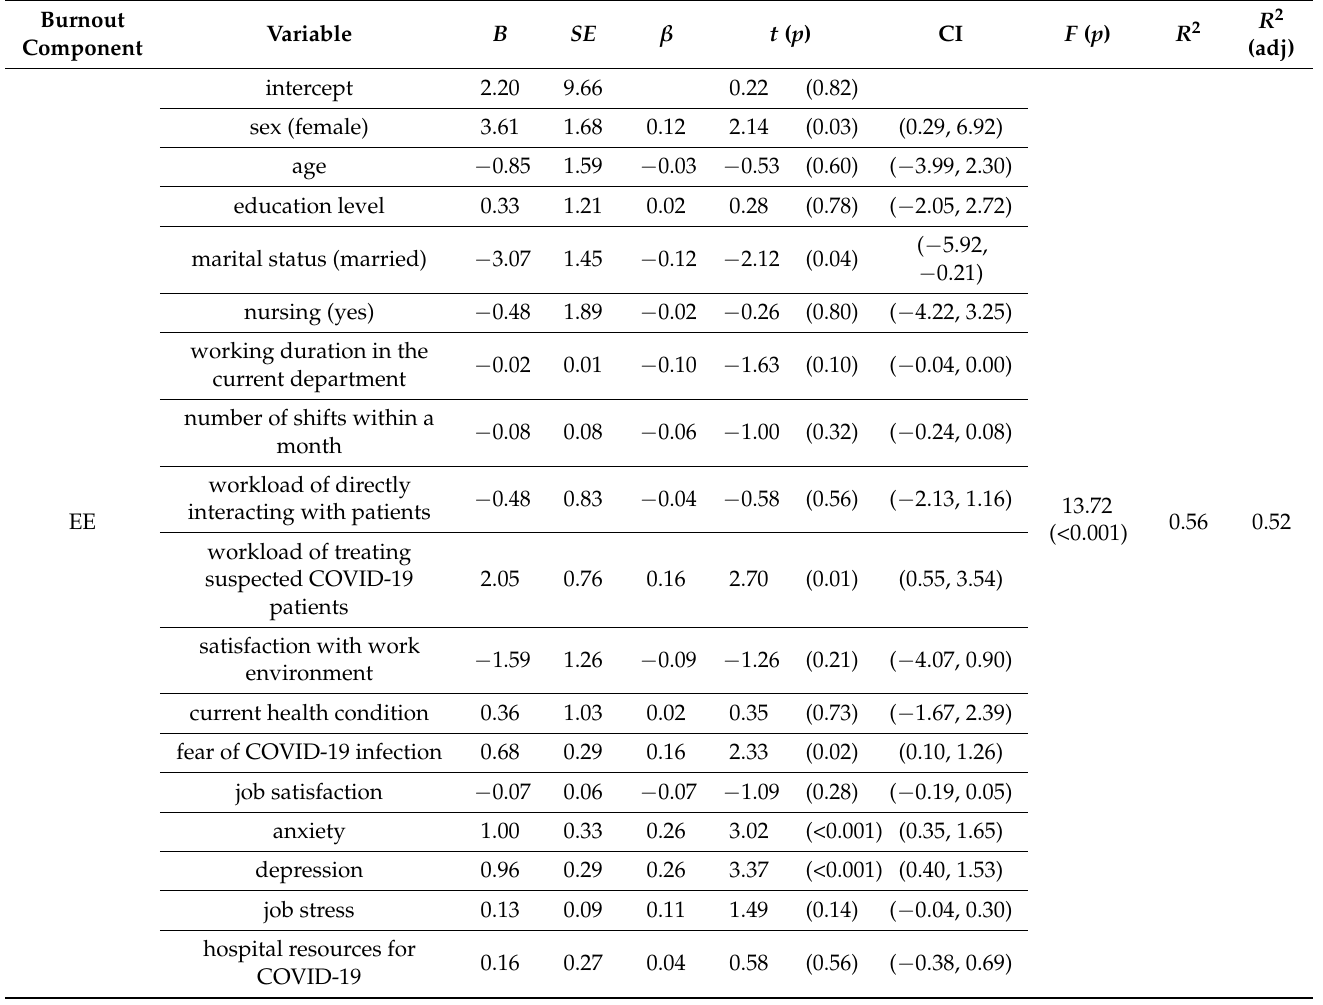
Table 2. Multiple linear regression analysis for burnout ( N =